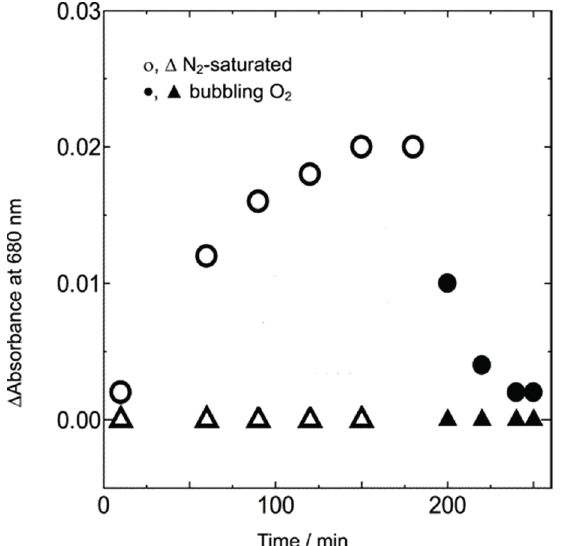
Figure 13. “Electron” absorption in TiO 2 @ 680 nm induced by visible illumination ( λ > 500 nm) of Au deposits and its quenching by ambient O 2 (adapted from [149]; copyright (2005) American Chemical